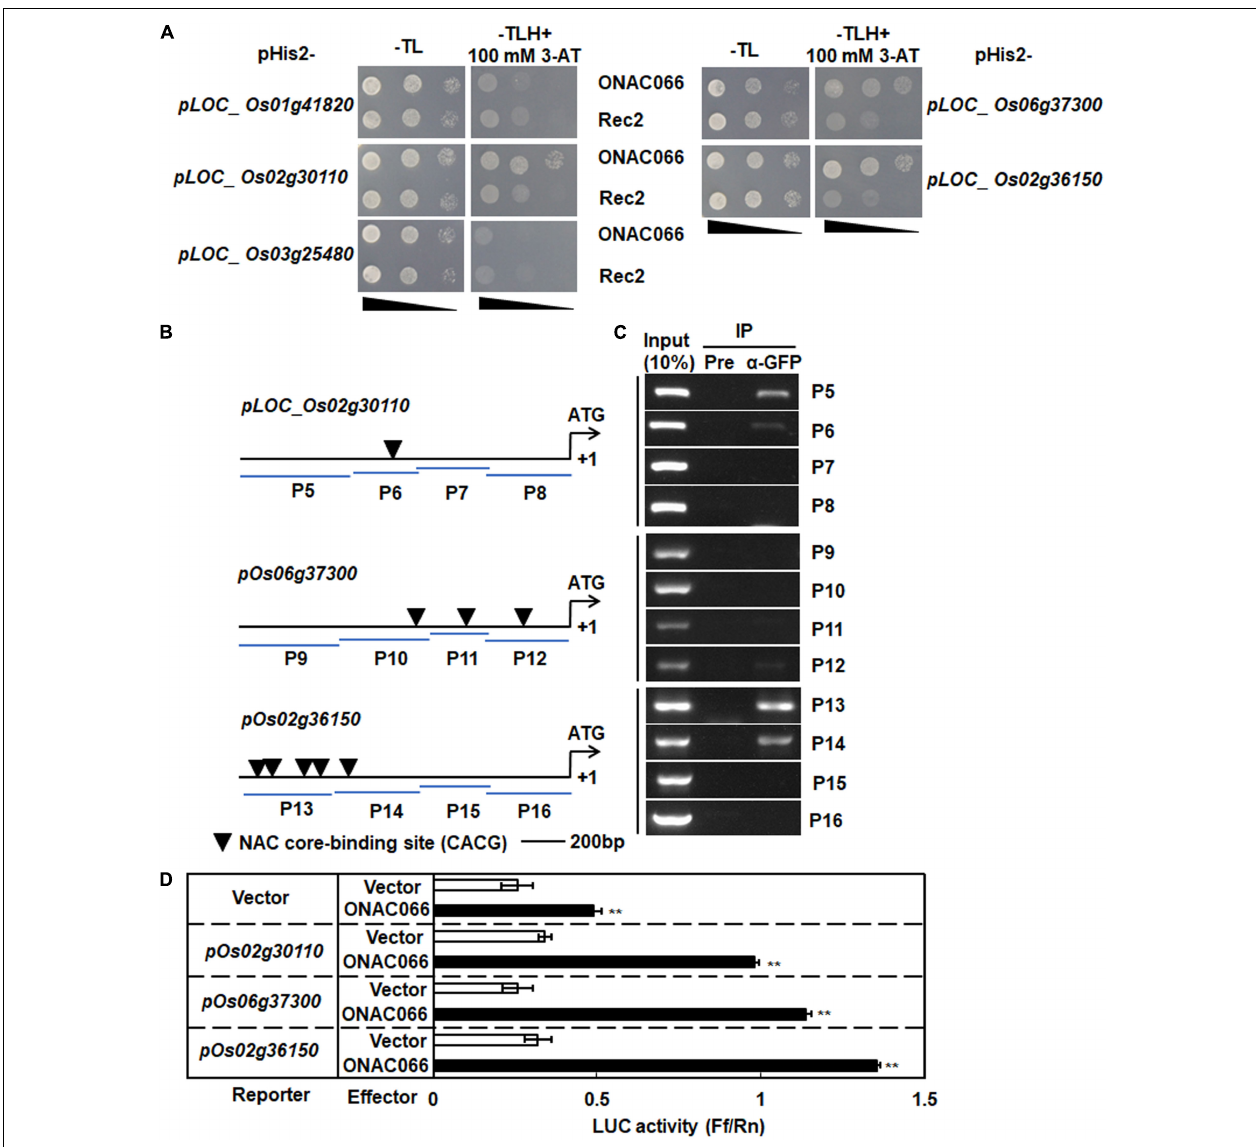
FIGURE 6 | ONAC066 activates promoters of three cytochrome P450 genes. (A) Growth performance of transformants on SD/-Leu-/Trp/-His medium containing 100 mM 3-AT. (B) Diagrams of putative NAC core-binding sites in the promoters of the selected cytochrome P450 genes. P5-P16 represent the probes used in ChIP-PCR assays. (C) ChIP-PCR analysis of ONAC066 binding to promoters of the selected cytochrome P450 genes. ChIP of ONAC066-GFP transgenic line using GFP antibody ( α -GFP) or pre-immune (Pre) serum was performed and precipitated DNA fragments were subject to PCR analysis using different primers for promoters of the selected cytochrome P450 genes. 10% of chromatin amount before IP was used as positive controls (input) and IP sample with pre-immune serum was used as a negative control. (D) Activation of promoters of the selected cytochrome P450 genes by ONAC066. Fragments of 1500 bp from start codon were used as promoters of the selected cytochrome P450 genes. Luciferase activity in protoplasts co-transfected with the reporter and different combinations of effectors was determined. Experiments were repeated at least three times with similar results, and results from one representative experiment are shown in panels (A,C) . Data presented in panel (D) are the means ± SD from three independent experiments and ** indicated significant difference at p < 0.01 by Student’s t -test, in comparison to empty vector.